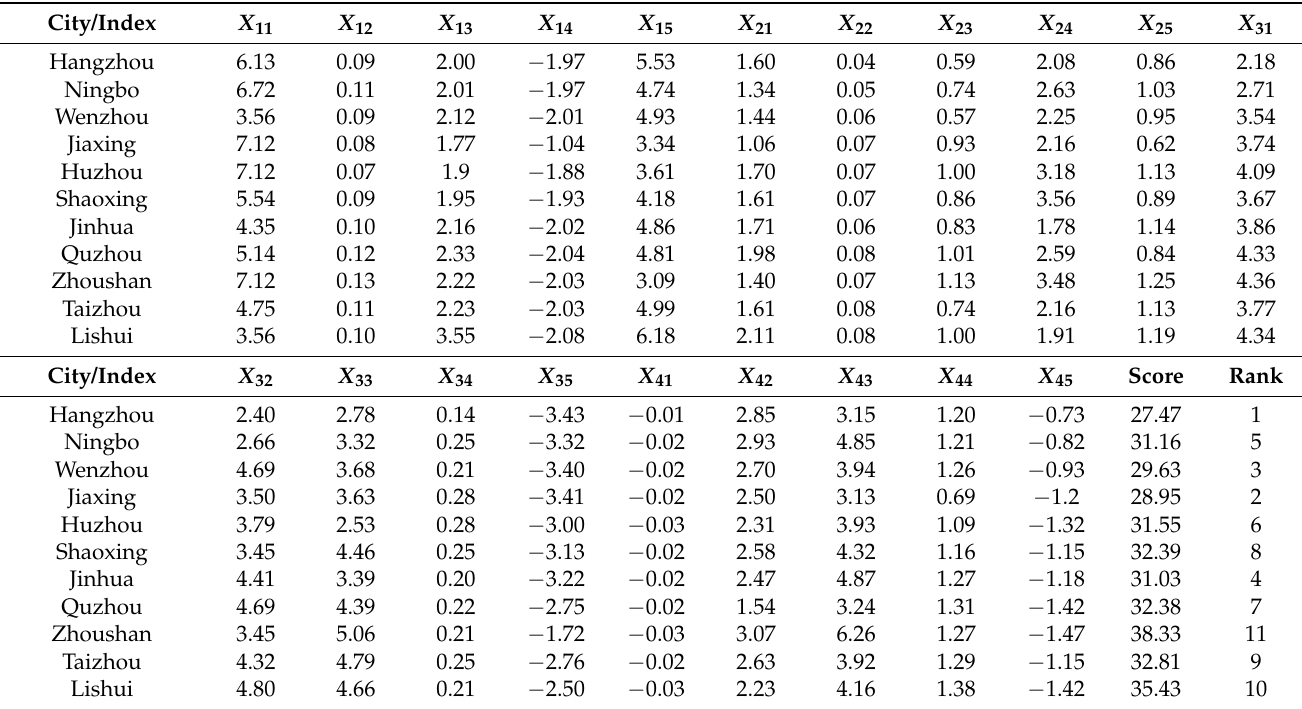
Table 7. Comprehensive evaluation value of hazard of disaster-causing factors in Zhejiang Province. ( × 10 − 4